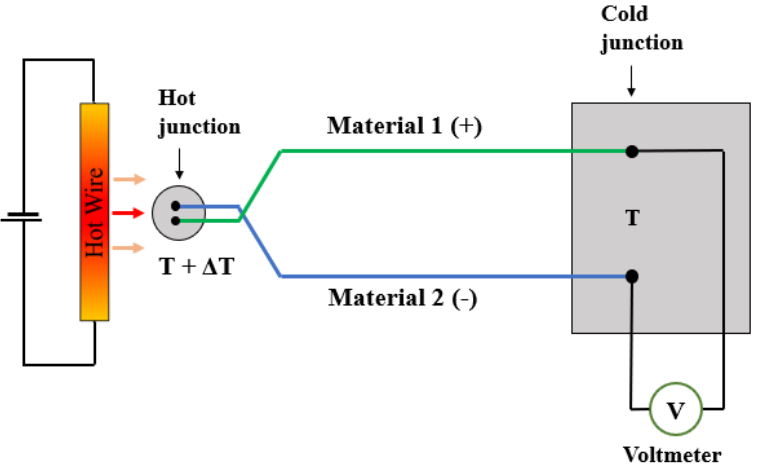
Figure 9. Illustration of the working principal of a classical thermocouple.